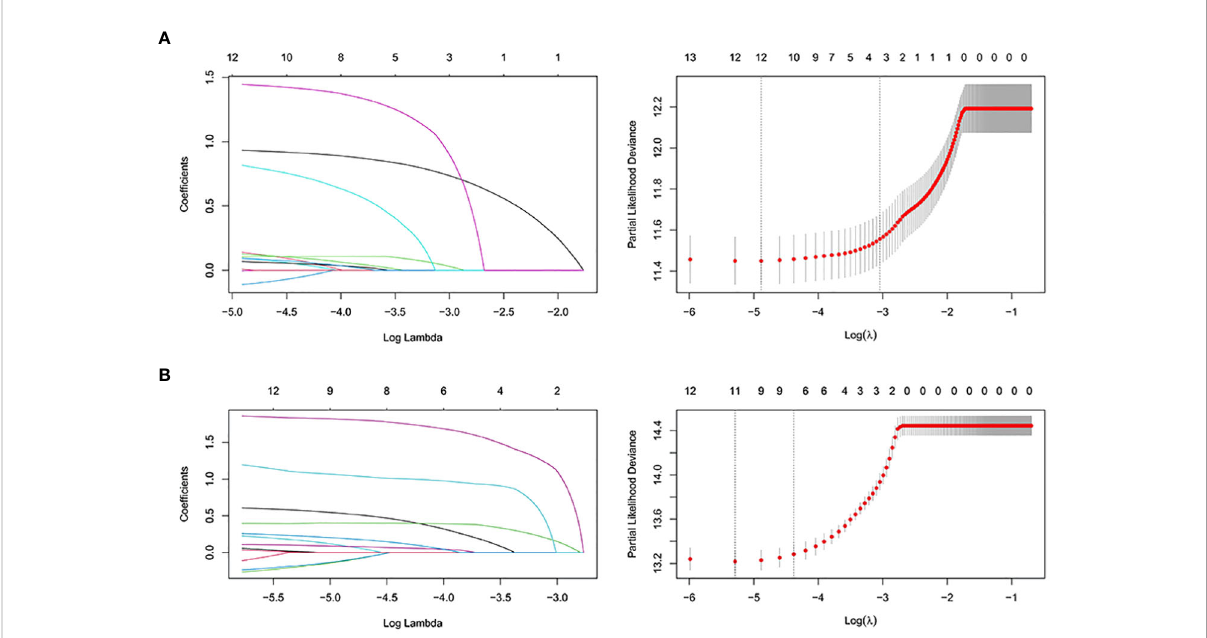
FIGURE 5 The LASSO regression used to select prognostic factors for OS and CSS. (A) LASSO coef fi cient pro fi les of variables for OS; LASSO analysis identi fi ed 12 variables for OS. (B) LASSO coef fi cient pro fi les of variables for CSS; LASSO analysis identi fi ed 12 variables for CSS. LASSO: least absolute shrinkage and selection operator.